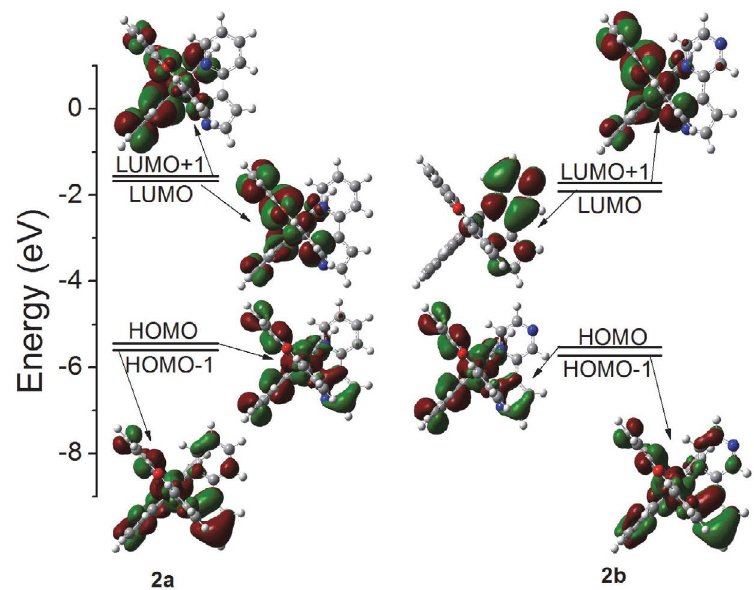
Fig. 4. The frontier molecular orbital energy-level diagrams of 2a–2b from DFT calculations.